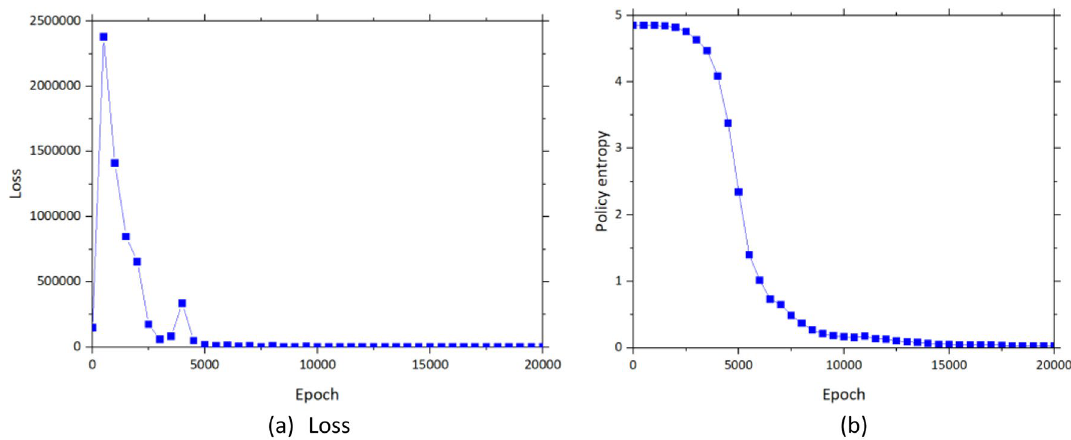
Figure 9. Reinforcement learning model performance ( a ) loss and ( b ) policy